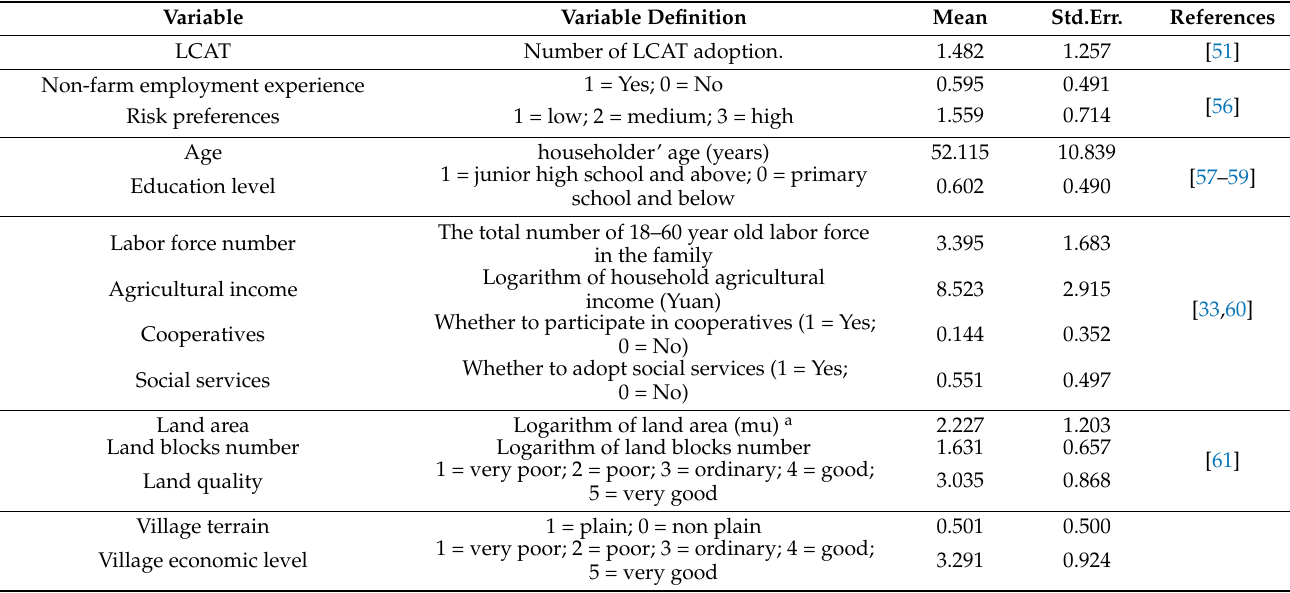
Table 2. Variable definitions and descriptive